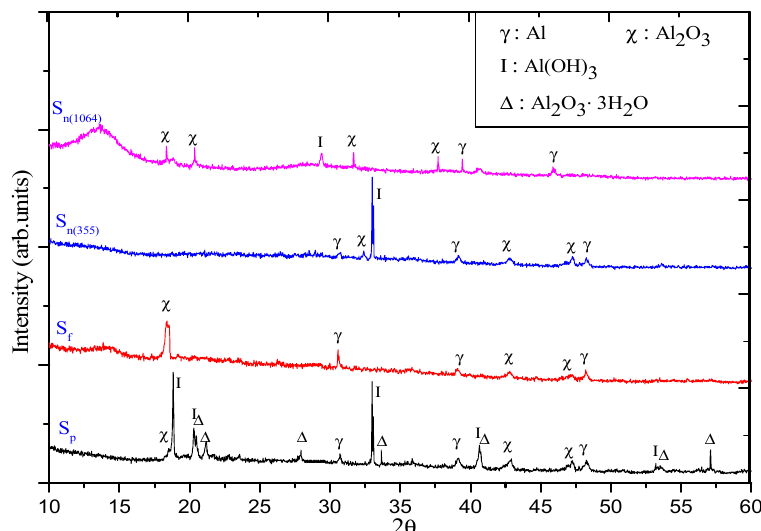
Figure 6. XRD image of NPs prepared at different conditions. S n(1064) : NPs obtained by 1064 nm, 5 ns pulses. S n(355) : NPs obtained by ns pulses with 355 nm. S f : NPs obtained by fs pulses. S p : NPs obtained by ps pulses. Table 1. Summary of energy dispersive spectroscopy (EDS) measurements. Wt % At